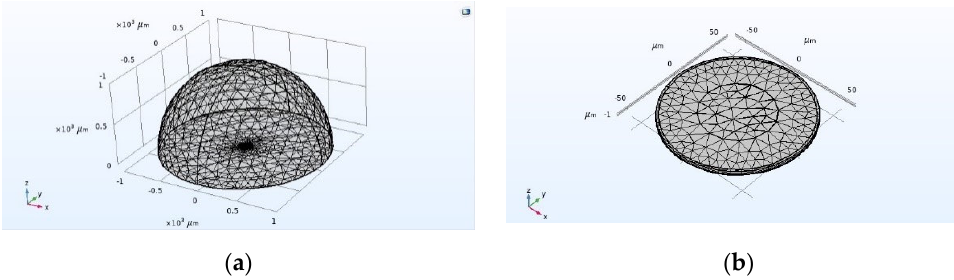
Figure 3. Meshing of CMUT finite element simulation model. ( a ) Meshing of the whole model, ( b ) Meshing of CMUT cell.